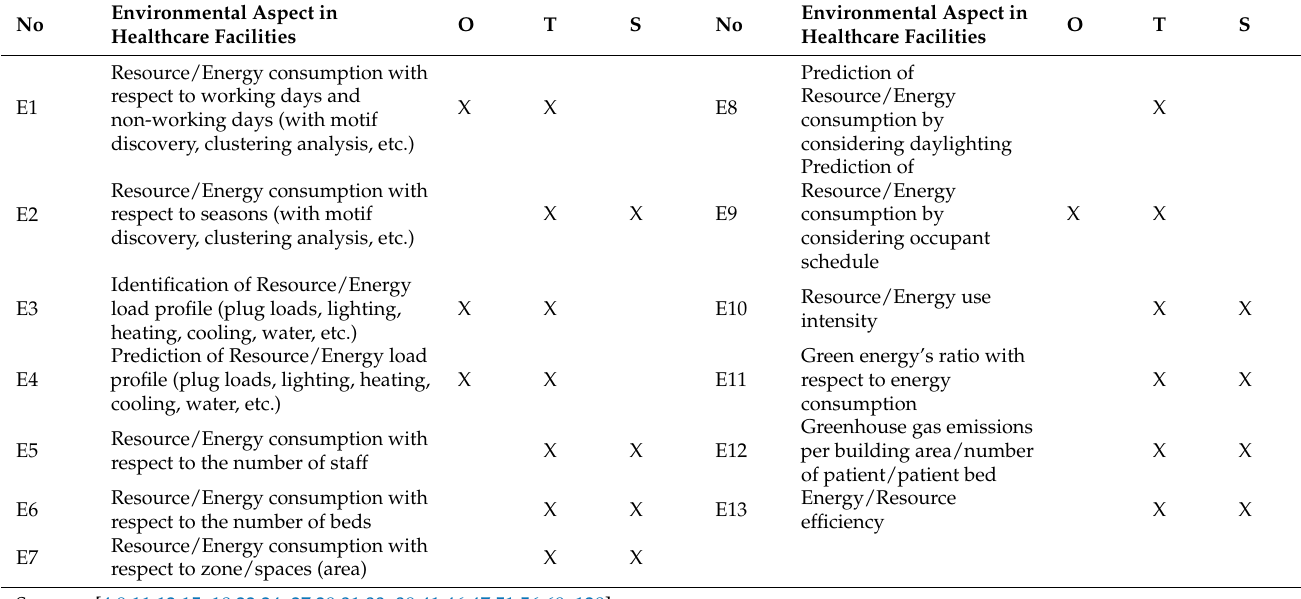
Table 1. Identification of FM KPIs for environmental aspect in healthcare facilities (O: operational, T: tactical, S: strategic).